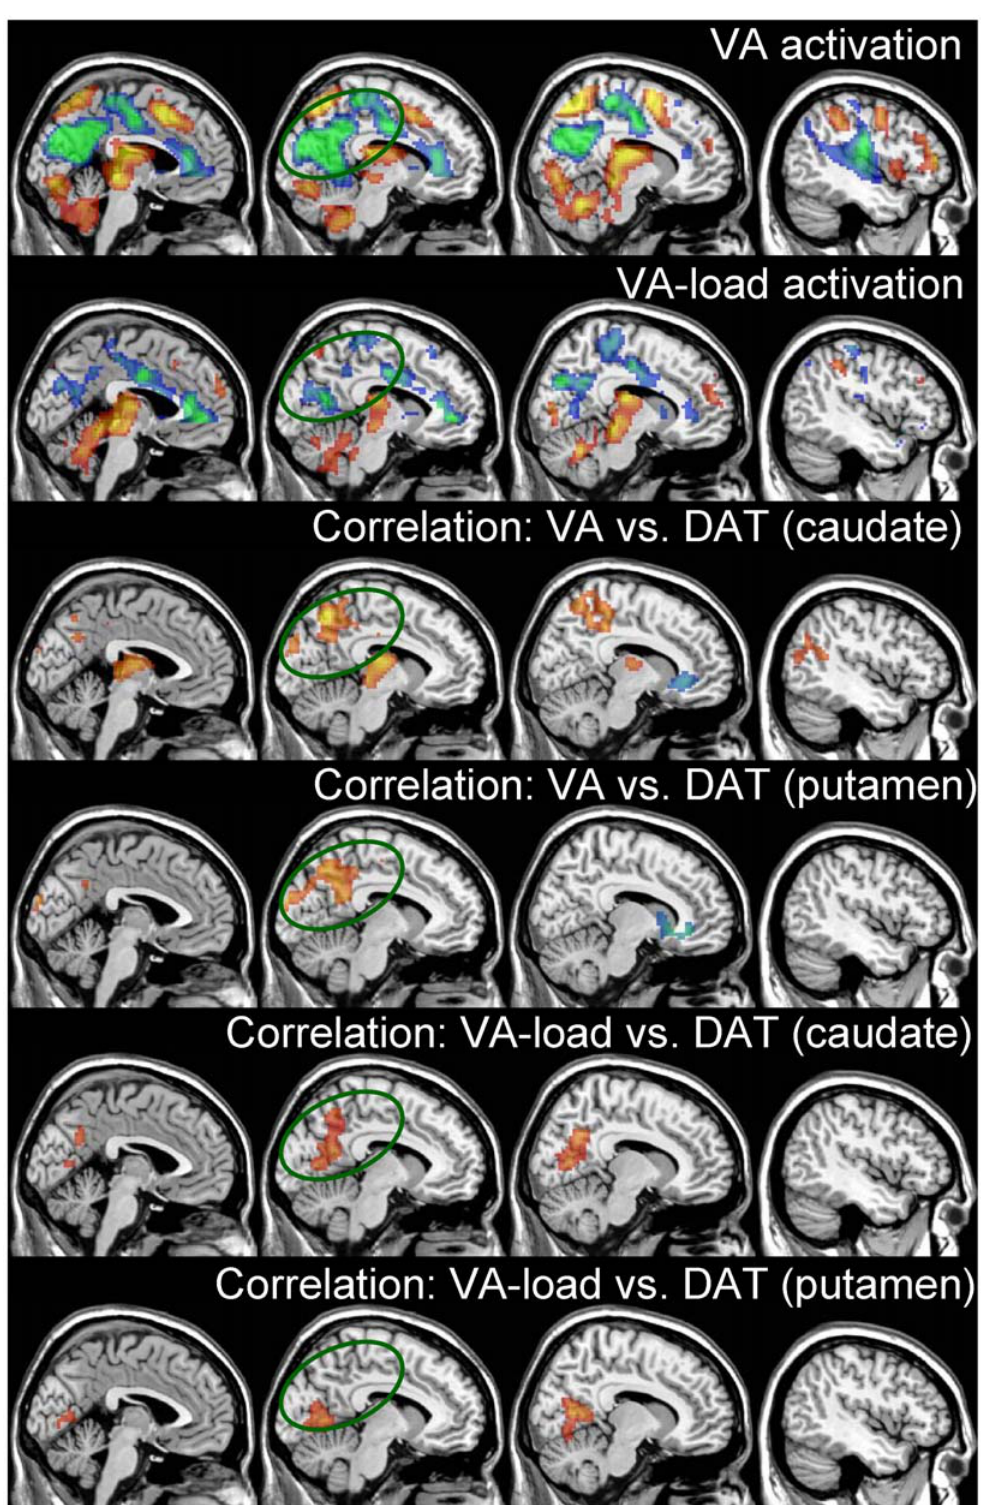
Figure 4. Brain activation and DAT. Sagital views of the brain activation/correlation patterns during VA tasks pattern rendered to a structural MRI image (ANOVA; T-score window=2.7 to 10; red-yellow: activation; blue-green deactivation). [First row] Average activation and deactivation across all three difficulty levels (2-, 3-, and 4-ball tracking); [second row] increased activation/deactivation caused by increased attentional load (4-ball tracking vs. 2-ball tracking); Statistical maps of positive (red-yellow) and negative (blue-green) correlations between BOLD-fMRI responses in the brain and [ 11 C]cocaine (DAT) radiotracer binding in caudate [third row] and putamen [fourth row] as well as VA-load responses and DAT in caudate [fifth row] and putamen [sixth row], rendered to a structural MRI image. Multiple regression (random-effects) analyses. Color maps are t-score windows: 2.7 to 5. The ellipse highlights the DMN regions.